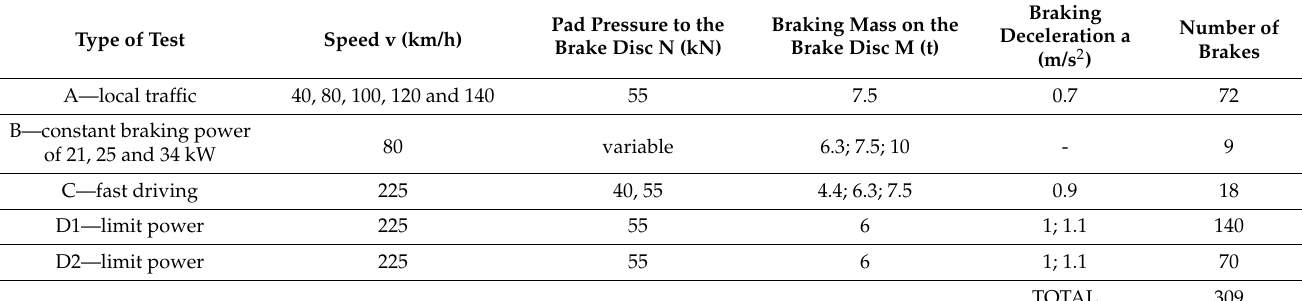
Table 1. Bench test